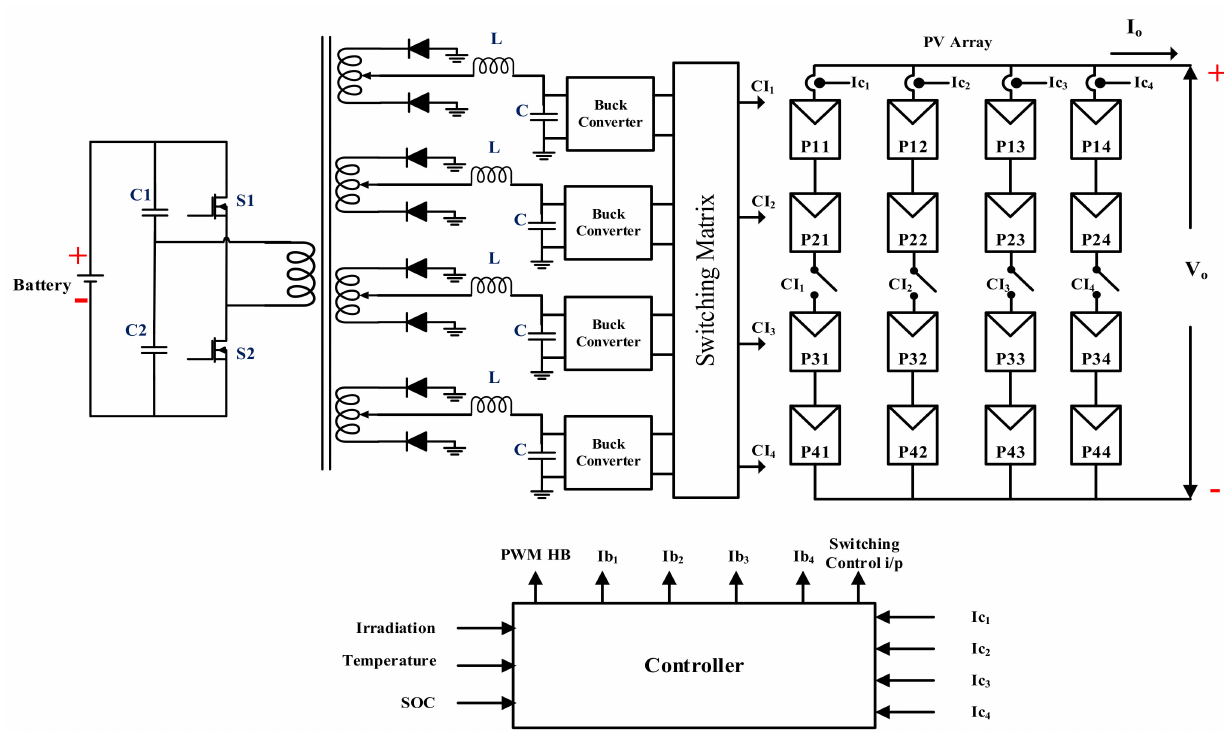
Figure 6. Implementation of the HBCI